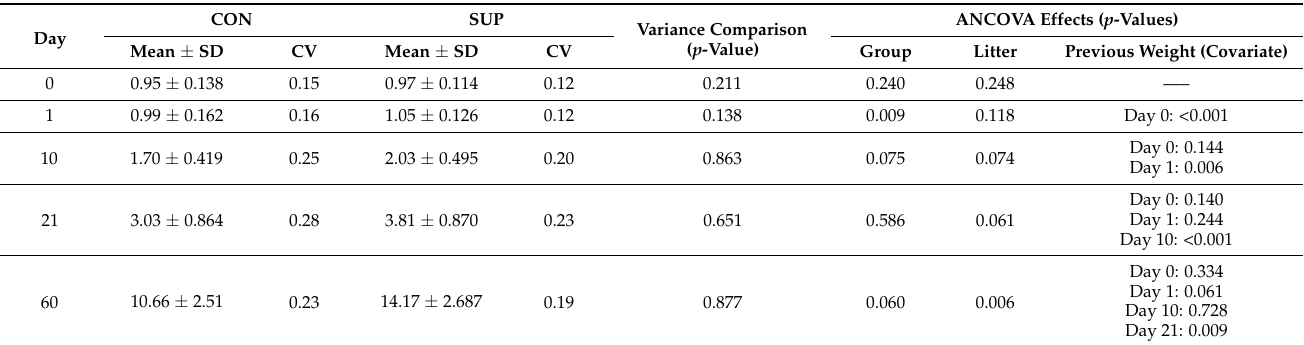
Table 4. Weights (kg) for survivor piglets under Q1 birth weight (1.100 kg) for days of age 0–60 from CON ( n = 30) and SUP ( n = 35) groups. SD: Standard deviation. CV: Coefficient of variation. CON: control group; SUP: colostrum supplemented group.